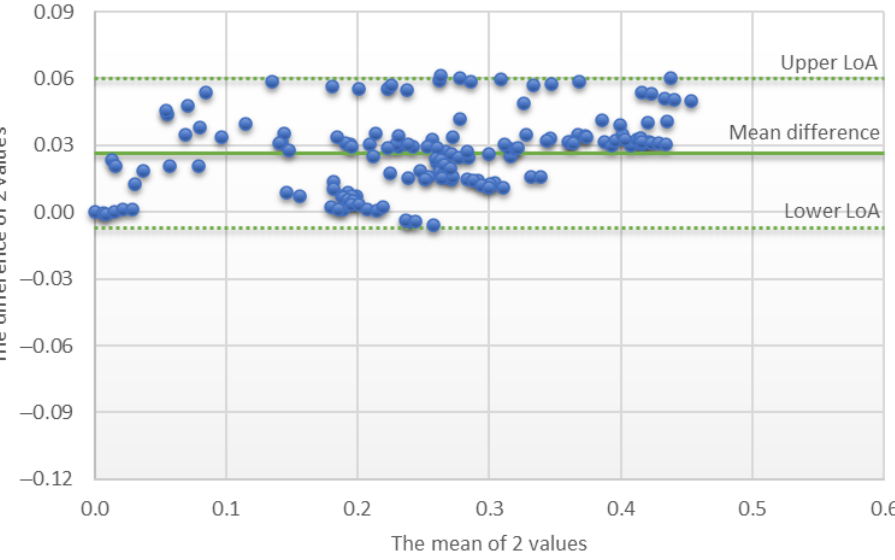
Figure 23. Bland and Altman plot — agreement between methods (deformation of right side of arch support frame).